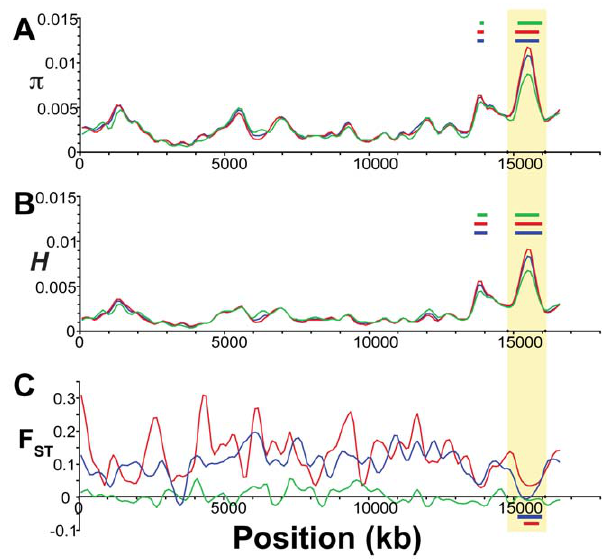
Figure 5. Evidence for balancing selection on Linkage Group III. Population genetic measures plotted along Linkage Group III. (A) Nucleotide diversity ( p ) and (B) heterozygosity ( H ) across all five (blue), the three freshwater (red), and the two oceanic (green) populations. (C) Population differentiation (F ST ) between oceanic and freshwater (blue), among freshwater (red), and between oceanic (green) populations. Colored bars indicate significant (p # 10 2 5 ) regions of elevated (above the plots) or reduced (below the plots) values of each statistic for the corresponding set of populations. Vertical yellow shading indicates the region of putative balancing selection used for candidate gene annotation.